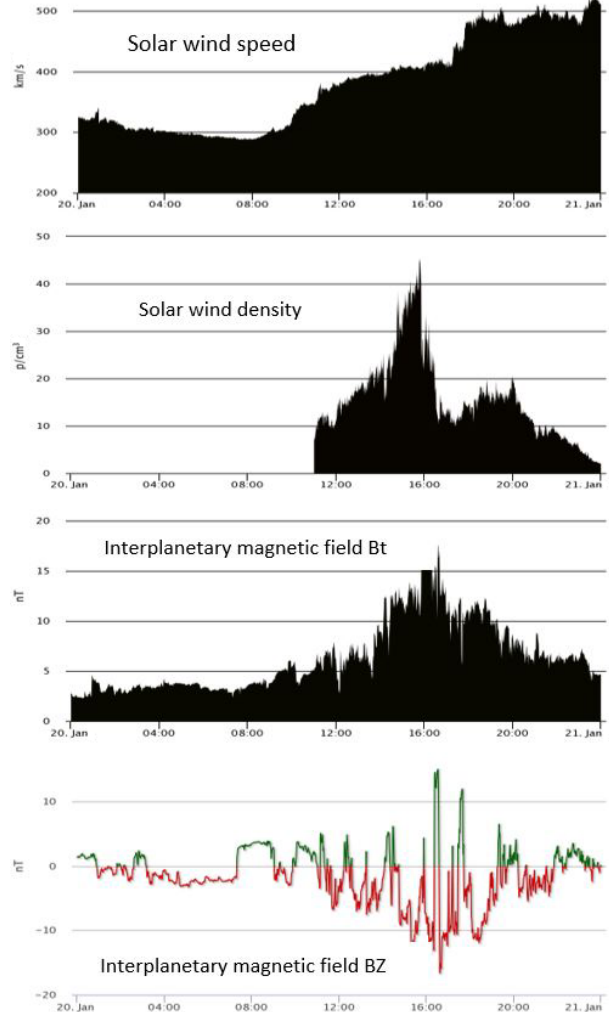
Figure 8. Parameters of solar wind (speed and density) and inter- planetary magnetic field strength on 20 January